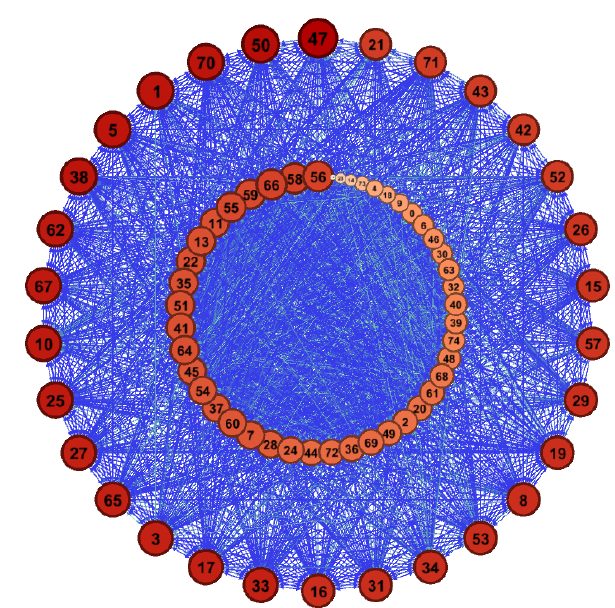
Figure 6. Visualizing G-causality sub-graph G ( X [ / 8] (90) , E [ / 8] (90) , W [ / 8] (90)) after eliminating the isolated nodes that correspond to non-stationary time series (note: each stationary time series has associated G-causality in this